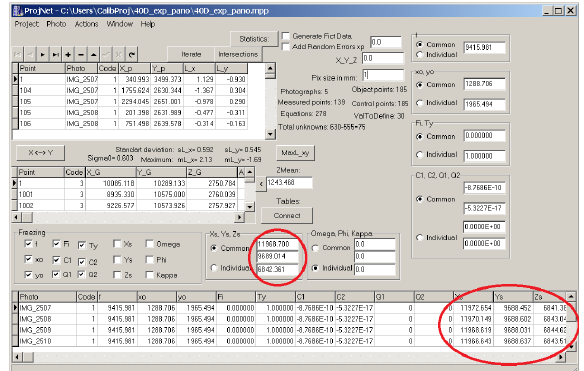
Figure 6. Software interface to calibrate the cameras with a common center of projection.